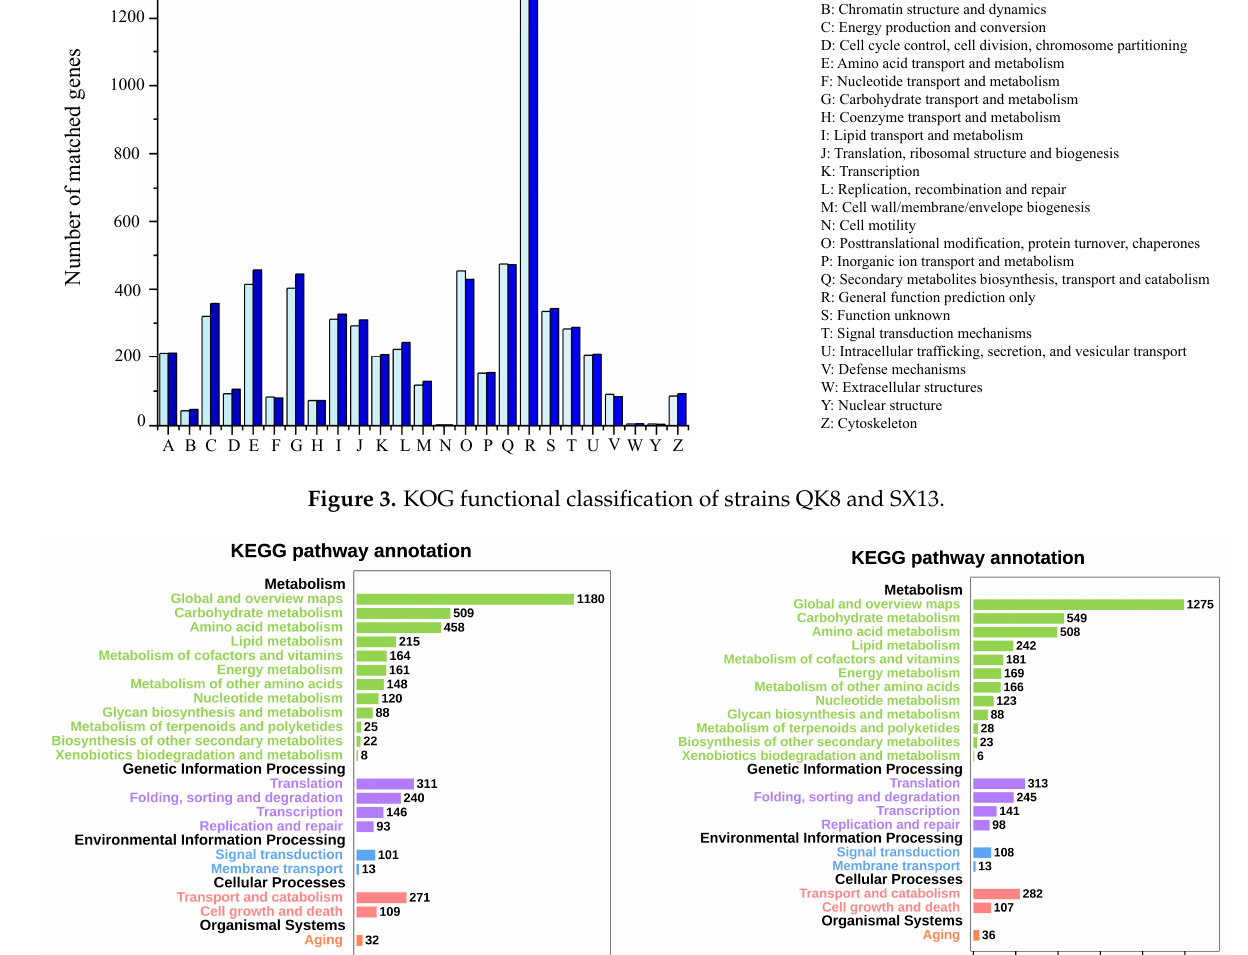
Figure 4. KEGG pathway annotation of strains QK8 ( A ) and SX13 ( B ).